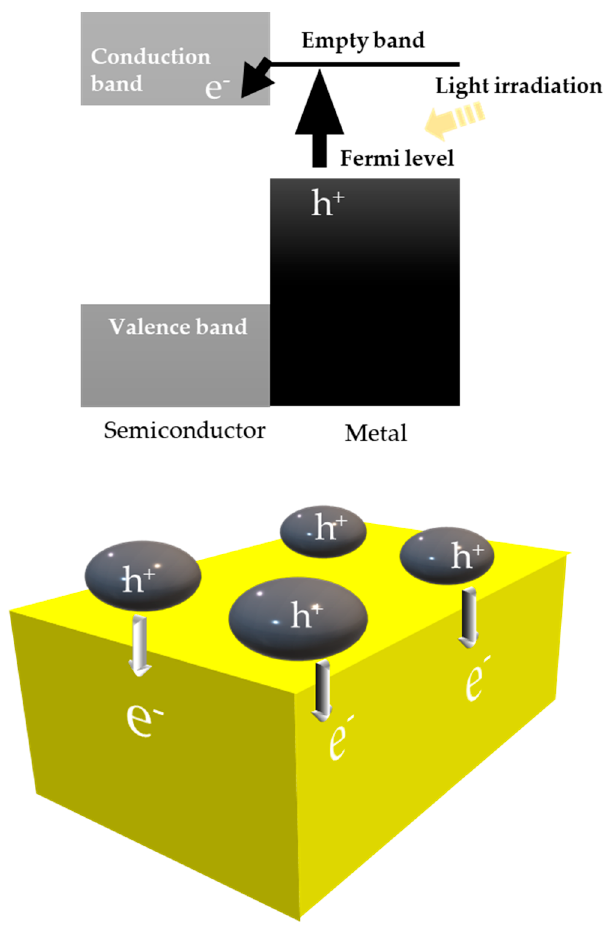
Figure 50. Excited carriers’ pathway in the hot carrier mechanism. Jiang et al. used Sr 2 Ta 2 O 7 , an ultrawide bandgap semiconductor, and loaded palla- dium onto it [70]. According to their UV-visible diffuse reflectance spectrum (UV-vis DRS), the bandgap of Sr 2 Ta 2 O 7 was determined to be 4.6 eV. Photocatalytic partial oxidation of methane was performed and the result of the action spectrum using a long-wave pass filter is shown in Figure 51a. The UV-vis DRS spectrum of Pd@Sr 2 Ta 2 O 7 shows a broad absorption of Pd, which was assigned to the interband charge transition in Pd, resulting in the generation of hot carriers. They found that there was no critical change between λ ≥ 250 nm and λ ≥ 300 nm. These results indicate that the bandgap excitation of Sr 2 Ta 2 O 7 is not a critical requirement to drive the reaction. The claim that the bandgap excitation was unnecessary was further verified by comparing the intensity using several long-wave pass filters and conversion or yield (Figure 51b). Because photon numbers through long- wave pass filters cannot be set at equal values for each experiment, the irradiation power density varies when using different filters. These results concluded that the conversion